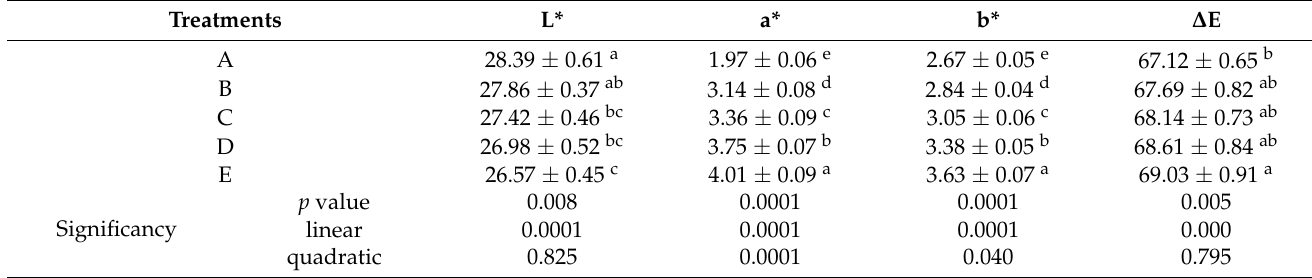
Table 4. Color parameters of date jam prepared with different amounts of powdered date press